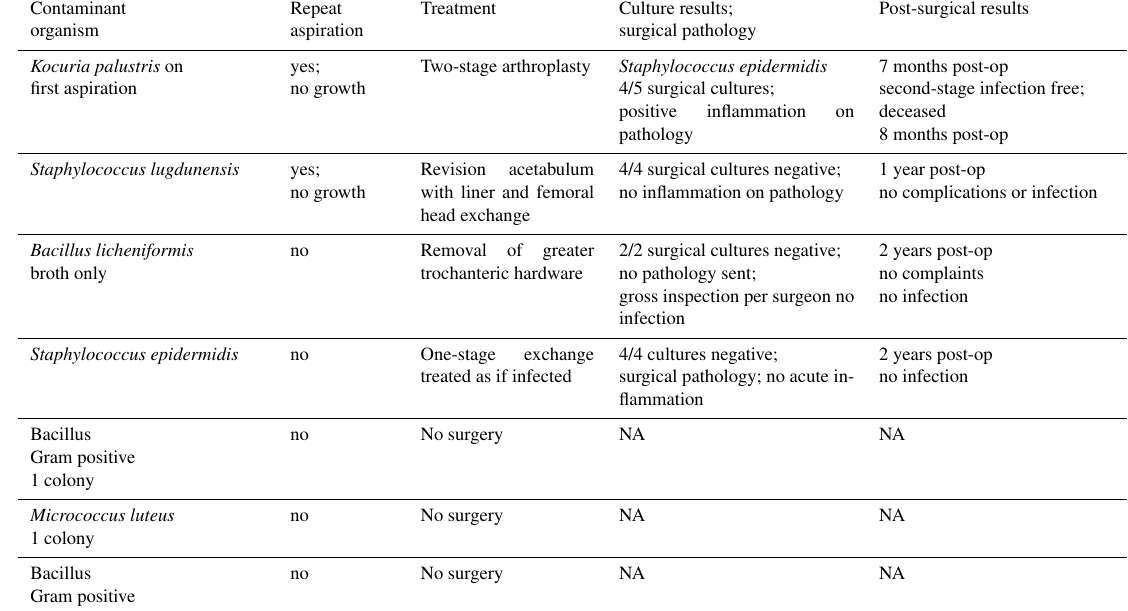
Table A1. Contaminant organisms with subsequent treatment. Contaminant organism